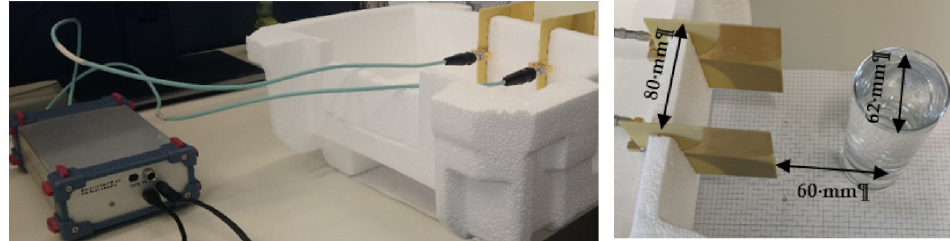
Figure 11. Measurement setup with Ilmsens radar.